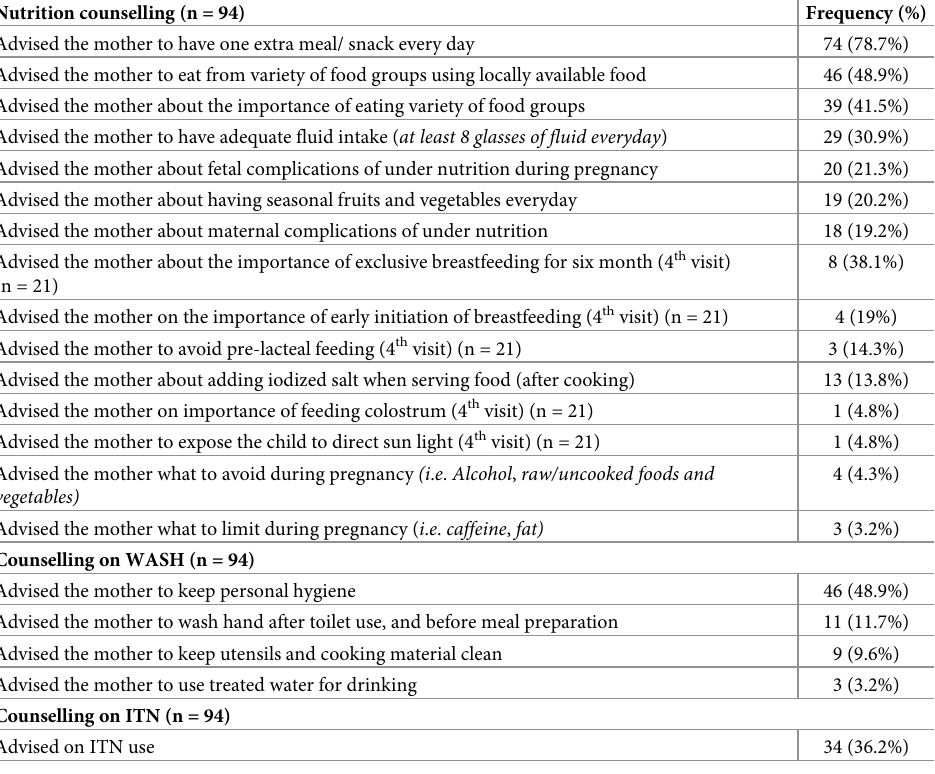
Table 7. Proportion of mothers receiving nutritional counselling at antenatal care service provision point. Nutrition counselling (n =